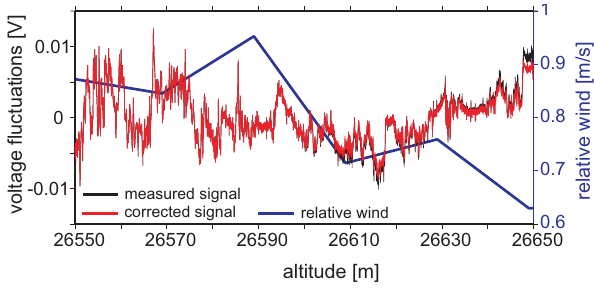
Fig. 7. Voltage fluctuations for the altitude region of 26550m– 26650m (see Fig. 5). The black line shows the measured fluctua- tions and the red line shows the fluctuation corrected for changes of background relative wind. The blue line presents the relative wind measured by radiosonde (used for the correction).